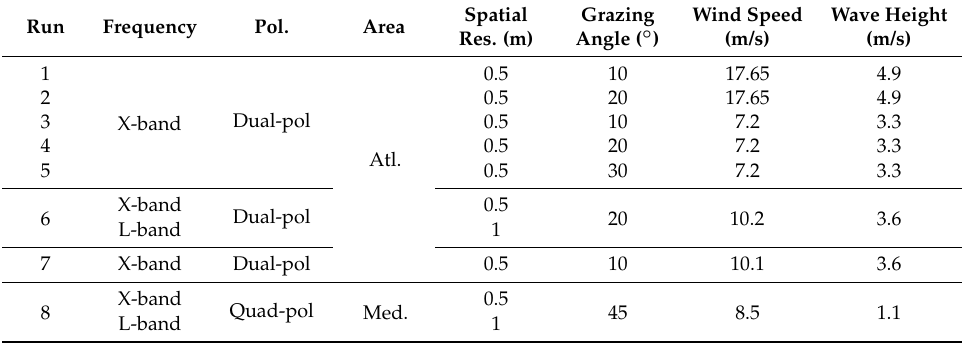
Table 3. Properties of the SETHI data sets. Both the range and azimuth spatial resolutions are equal.